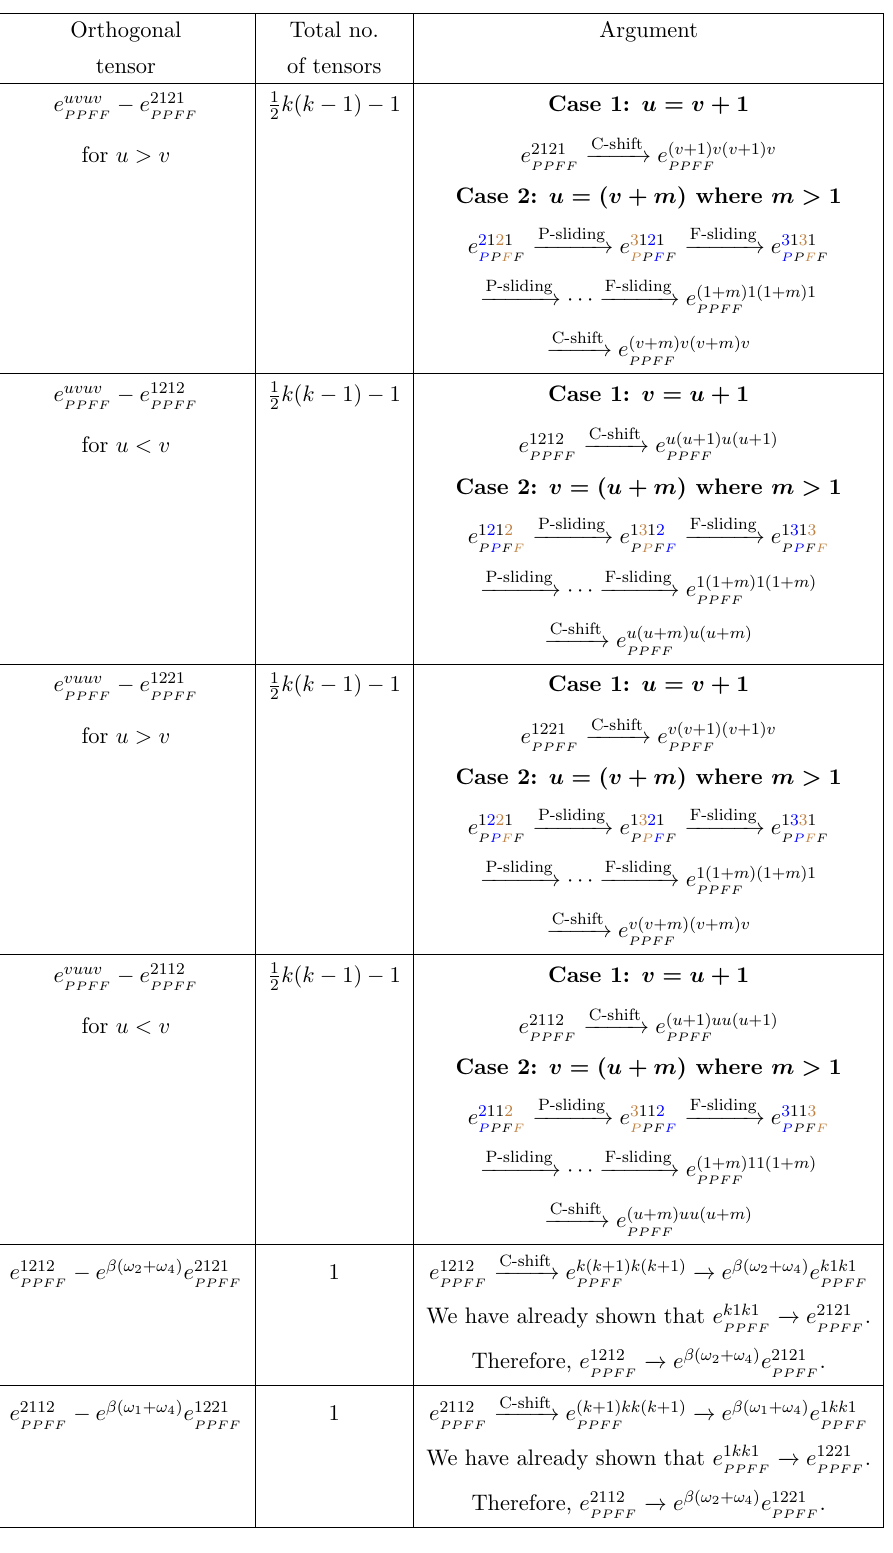
Table 11 . Arguments for the tensors in the PPFF sector orthogonal to the array of 4 point contour